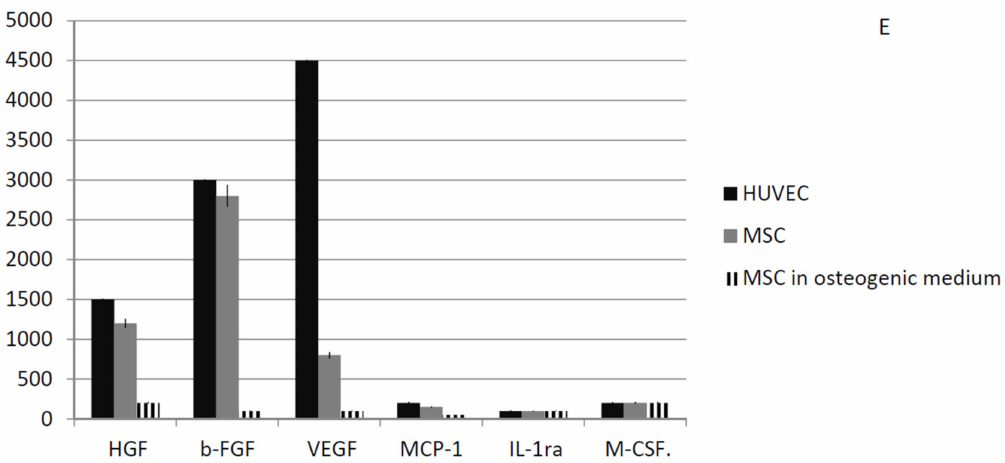
Figure 4. ( A , B ) SEM analyses of MSC in presence of no differentiative medium cultured onto OGI surfaces; ( C ) immunohistochemical test against phalloidine (red) ( D ) Quantification of growth factor release pg/mL. Statistically significant differences are indicated as ** p < 0.01; ( E ) Summarized graph about the quantification of growth factor release from the MSCs, osteoblastic like cells, and HUVEC cells.